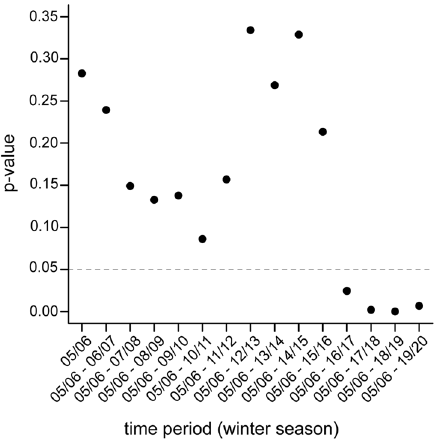
Fig. 3 Calculated p-values for the relation between colony losses and Nosema spp.-infection status using cumulated data for the numbers of infected colonies. Each data point represents the cumulative number of infected colonies summed over the time window indicated on the x -axis. The total numbers per time window are given in Table 2. The y -axis gives the respective p -value of the χ 2